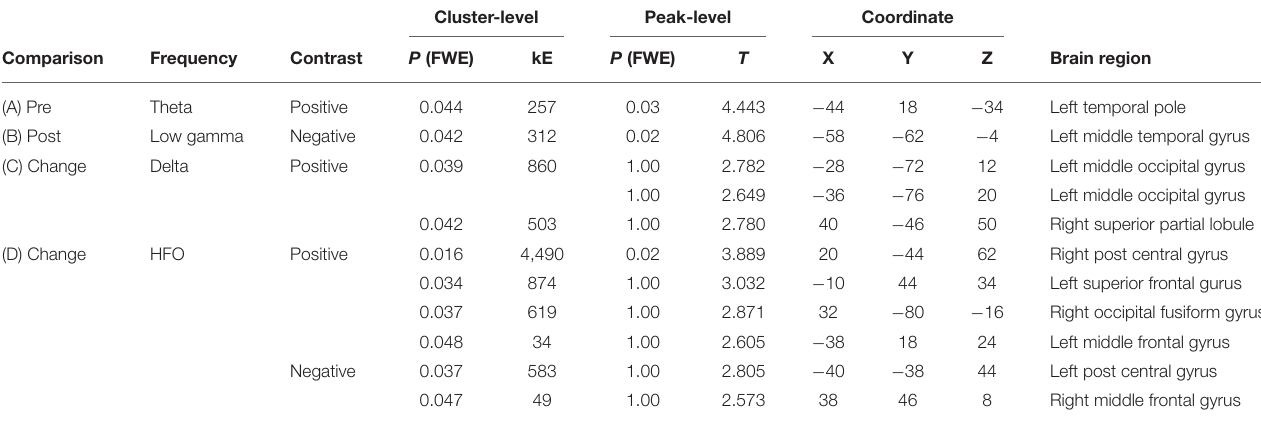
TABLE 2 | Association of resting-state oscillatory intensity with the subjective level of pain and efficiency (corresponding to Figure 4 ).